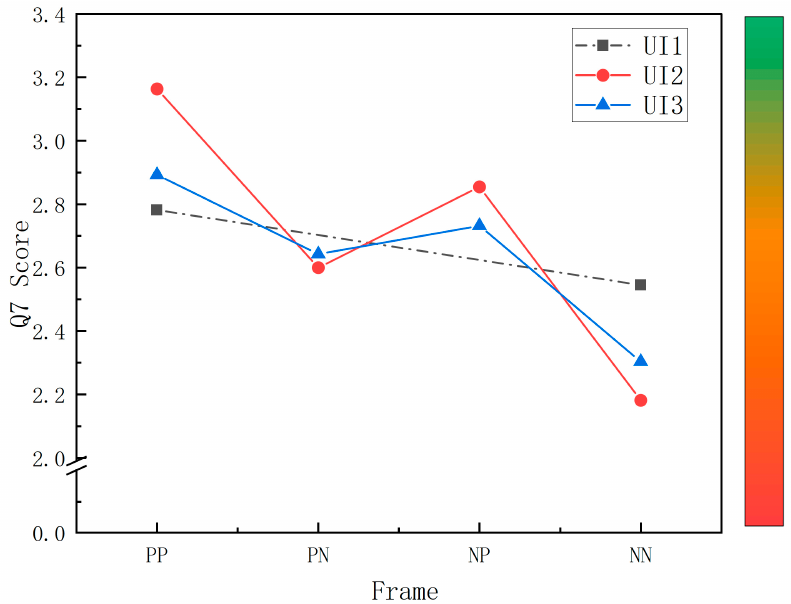
Figure 9. The interactive effects of Q7 score between UI-levels and presentation frames. Note.